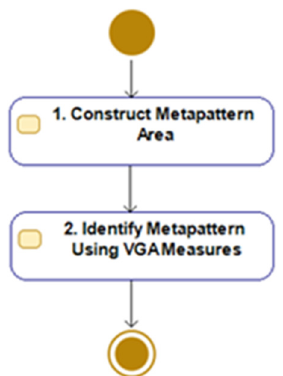
Figure 8. Algorithm of spatial meta-pattern identification (simplified).